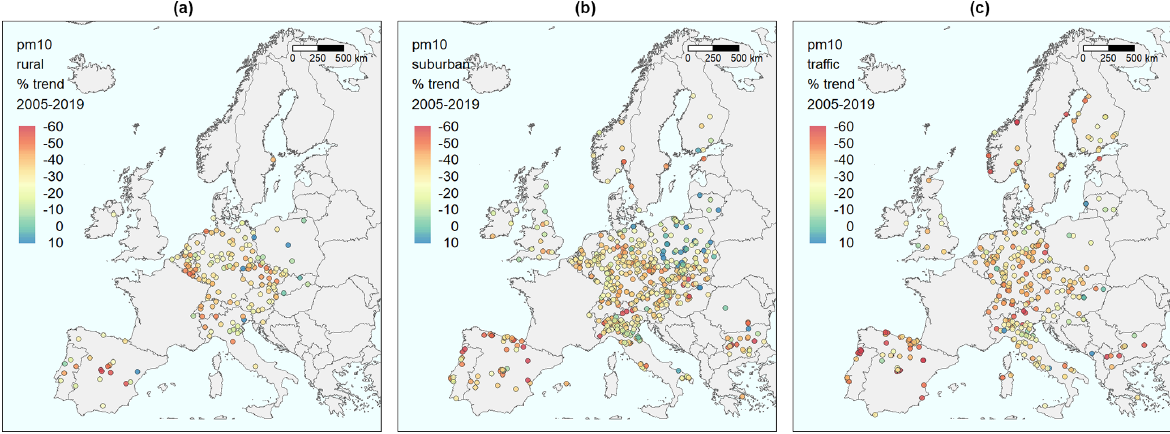
Figure 8. Maps of stations in Europe with the percentage change in expected concentrations from 2005 to 2019, relative to the initial level in 2005, based on the meteorology-adjusted trend for PM 10 . (a) Background stations in rural areas. (b) Background stations in urban/suburban areas. (c) Traffic stations.